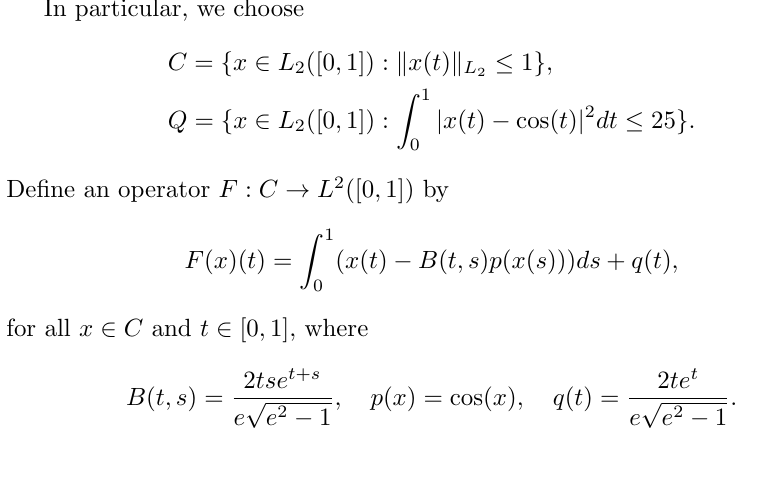
Figure 2. Example 1. Left: m = 500; Right: m =